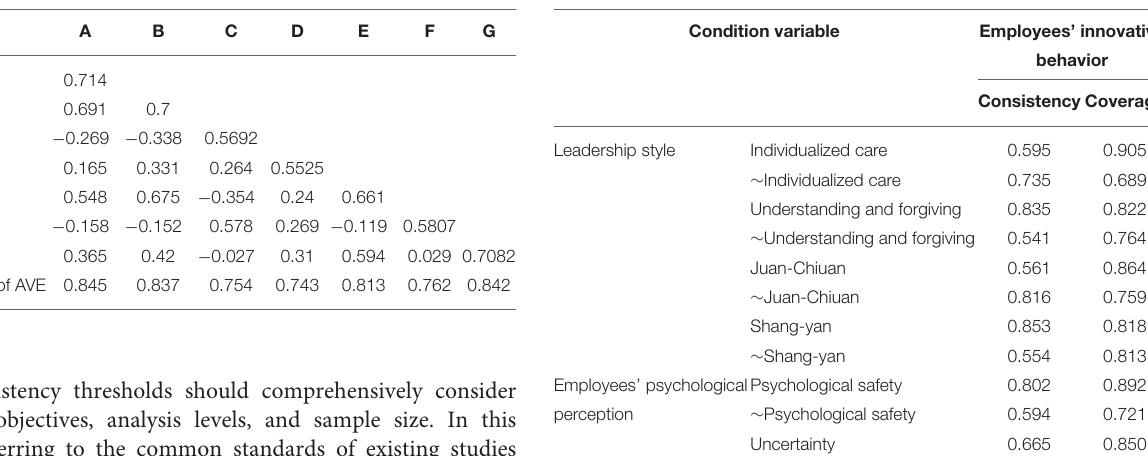
TABLE 3 | Discriminant validity analysis results. TABLE 4 | Single factor necessity analysis